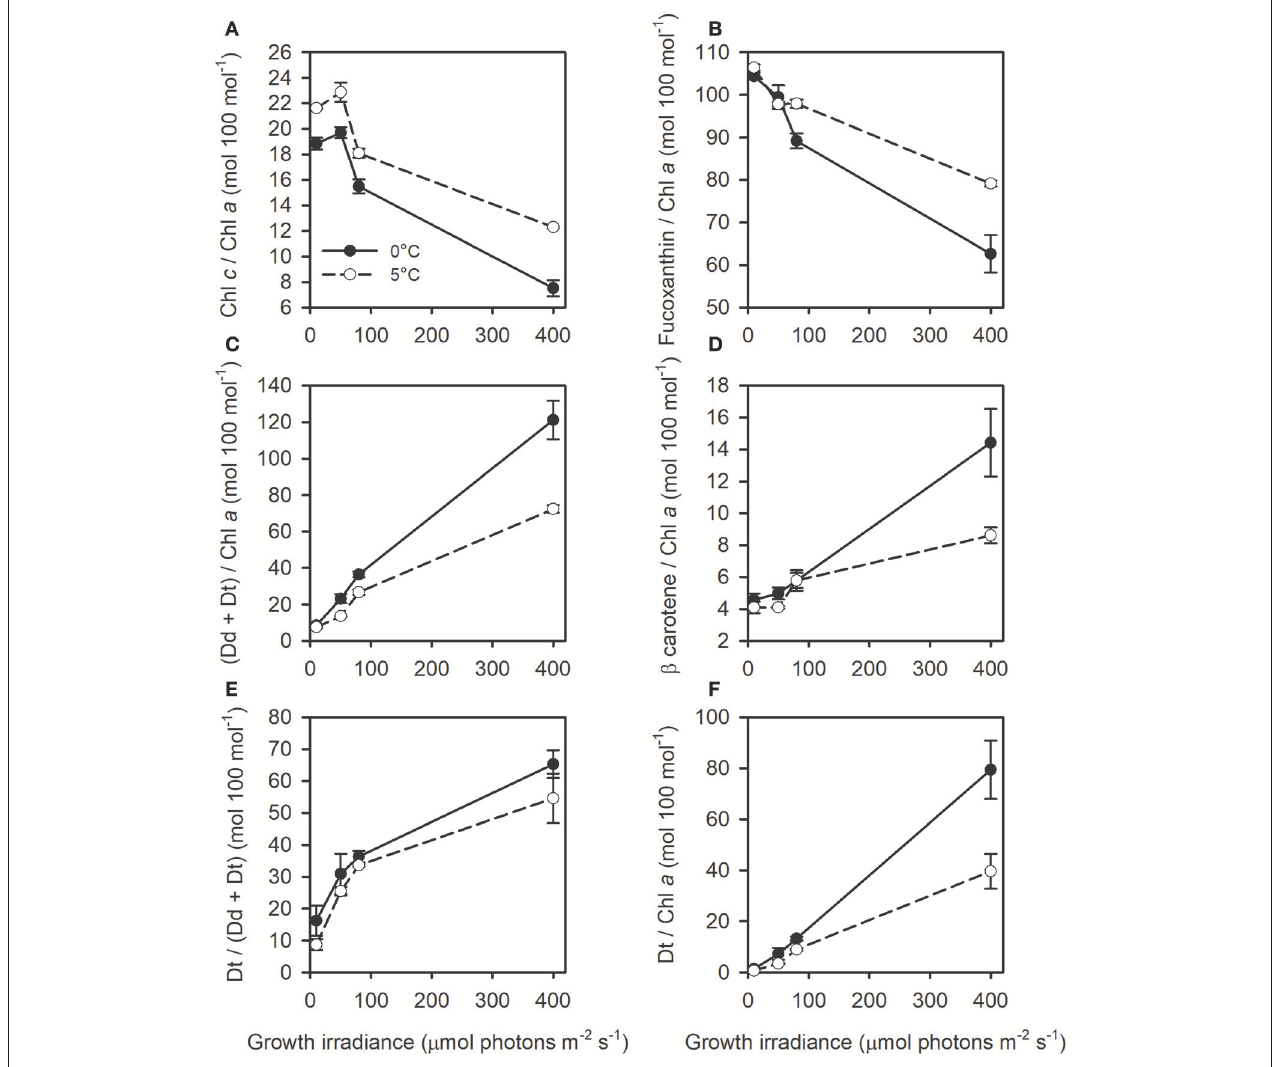
FIGURE 2 | (A) Chl c /Chl a , (B) Fucoxanthin/Chl a , (C) (Dd + Dt)/Chl a , (D) β -carotene/Chl a , (E) de-expoxidation ratio (DES = Dt/(Dd + Dt)x100), and (F) Dt/Chl a as a function of growth irradiance in T. gravida cells acclimated to 0 ◦ C (closed circles) and 5 ◦ C (open circles). All pigments ratios (but Dt/(Dd + Dt)) are expressed in moles relative to 100mol Chl a . See Table 1 for parameters definition. Each data point is the mean of three independent cultures, error bars represent standard